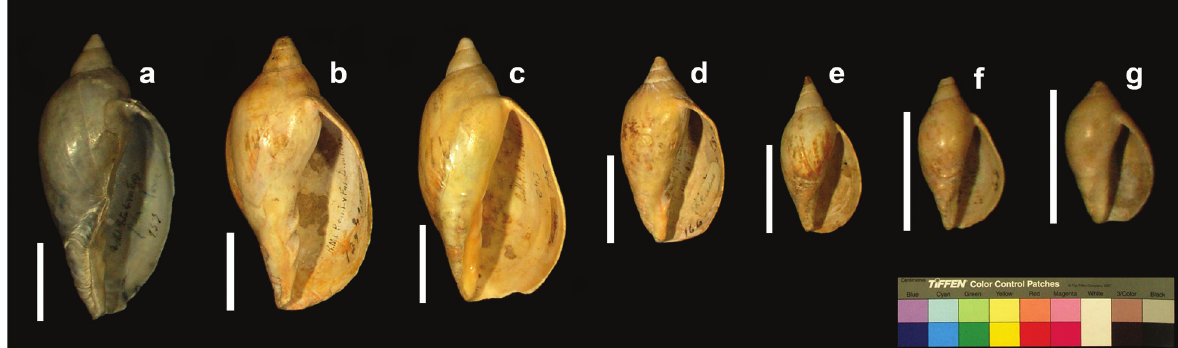
Figure 49. Specimens of Voluta paradoxa typica figures by Lahille (1895). See references on Table 19. Scale bars: 5 cm.